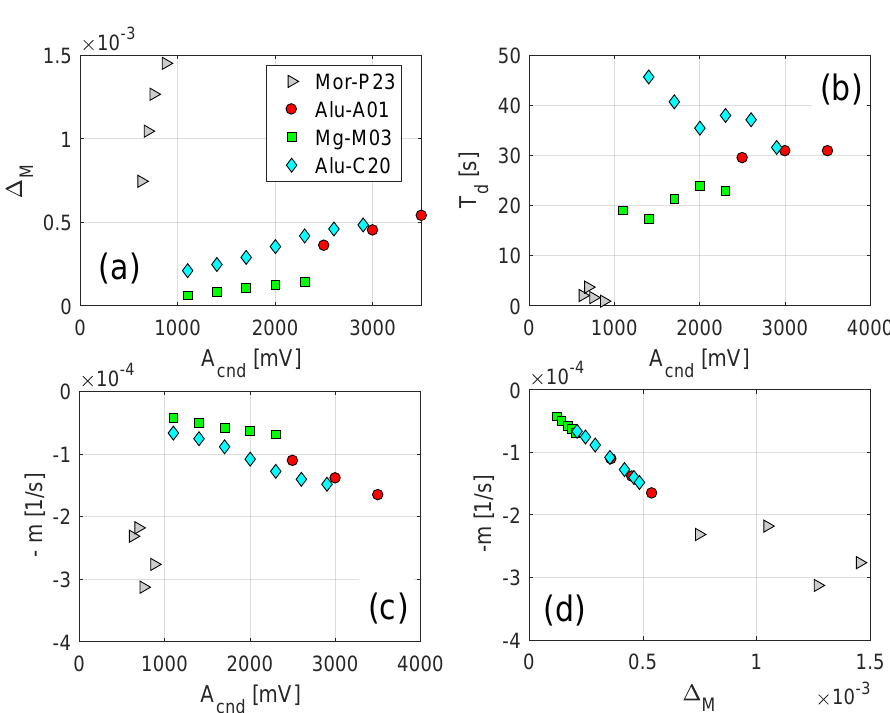
Figure 9. Indicators quantifying the evolution of the velocity variation in time during relaxation as a function of the conditioning amplitude: ( a ) ∆ M is the velocity variation at t = 0; ( b ) T d is the time at which δ c / c = 0.5 ∆ M ; ( c ) m is the slope of the curve in the log space around t = T d , i.e., in the logarithmic recovery phase; ( d ) parameteric plot of m vs. ∆ M